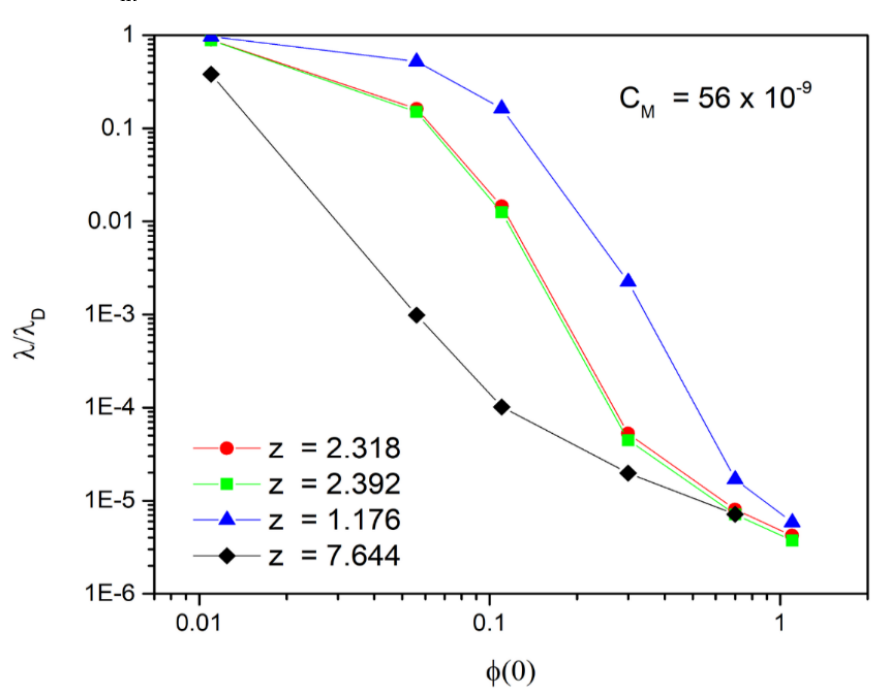
λ for all the toxins as a function of ϕ ( 0 ) (V) for C M = 56 × 10 − 9 mol Figure 6. Ratio of (cid:3090) λ D